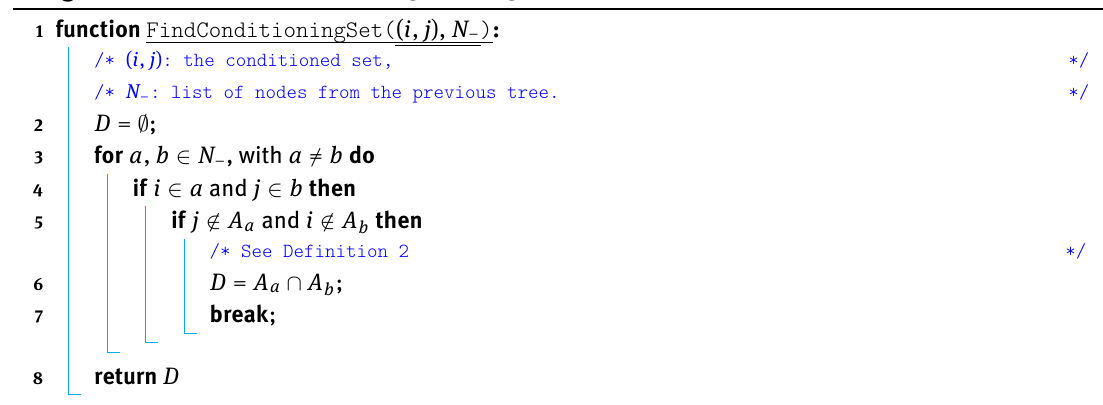
Algorithm 5: Gets the conditioning set of a given conditioned